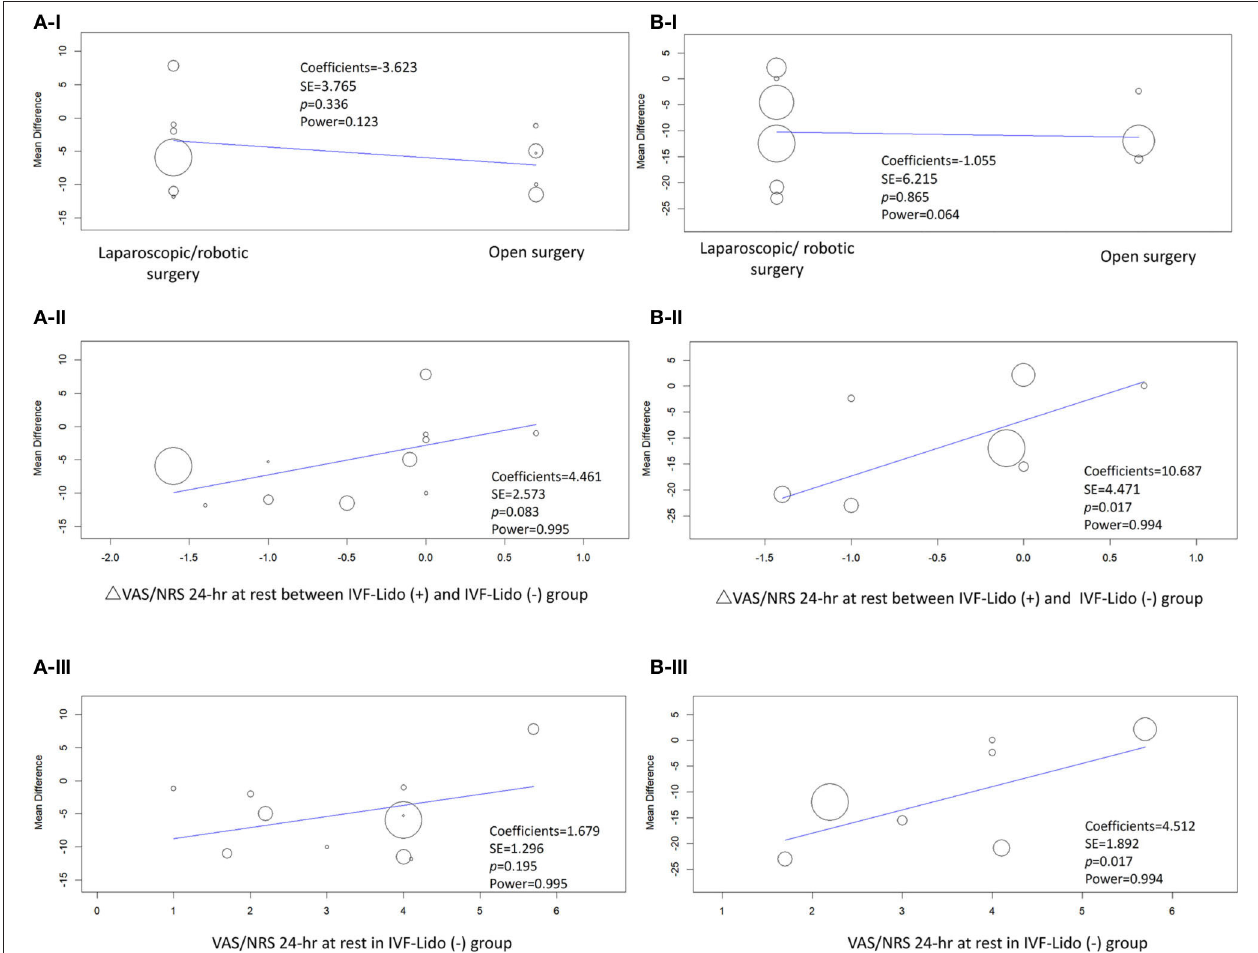
FIGURE 6 | Meta-regression of studies in (A) time to first flatus and (B) defecation. Covariates included (I) open or laparoscopic/robotic surgery, (II) changes ( 1 ) in the pain score for 24h at rest between IVF-Lido ( + ) and IVF-Lido (-) groups; (III) the pain score for 24h at rest in the IVF-Lido (-) group was analyzed. IVF-Lido, intravenous infusion of lidocaine; VAS, visual analog scale; NRS, numeric rating scale; SE, standard error; h,